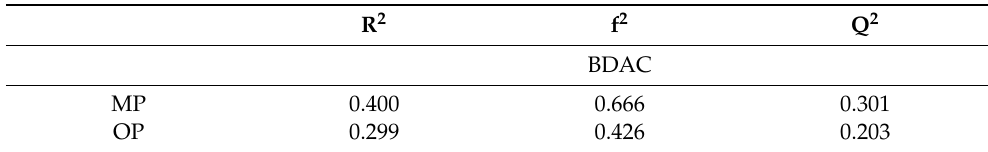
Table 5. Assessment of R 2 , f 2 and Q 2